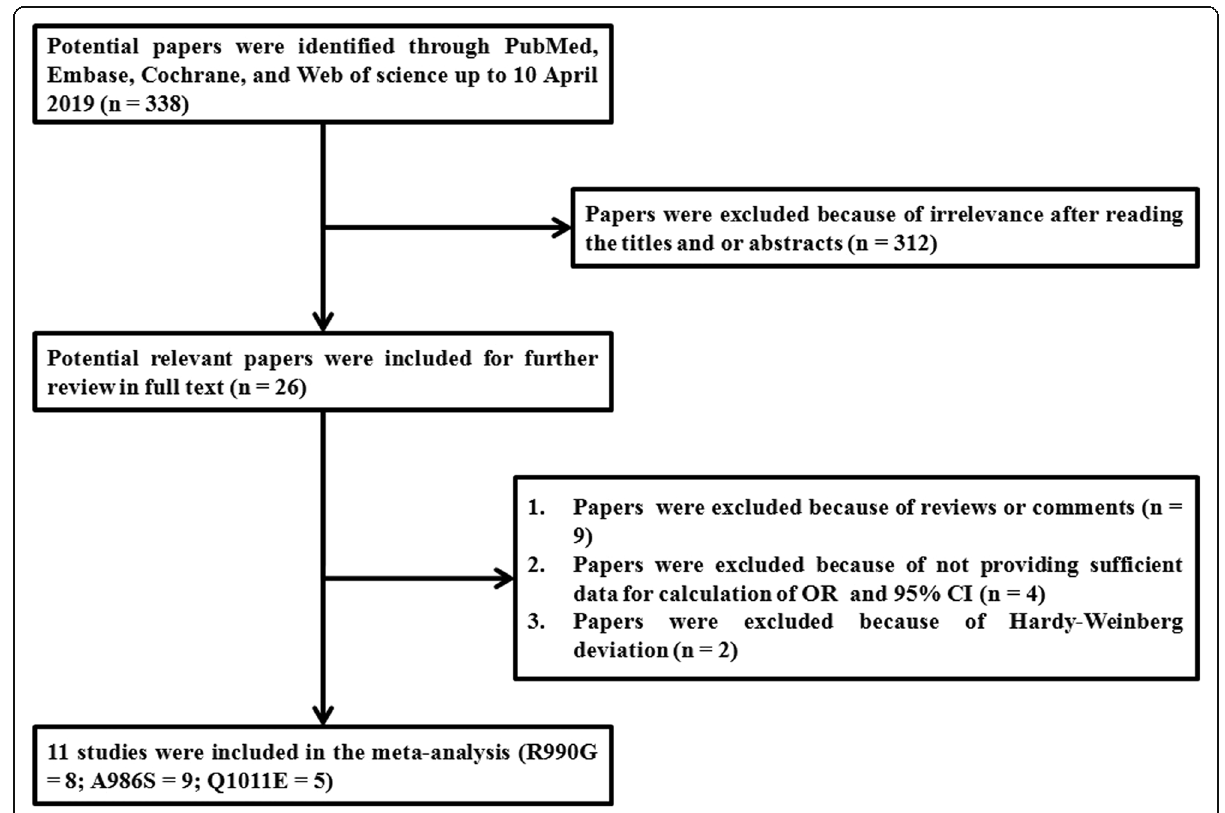
Fig. 1 A flowchart of eligibility pathway in our